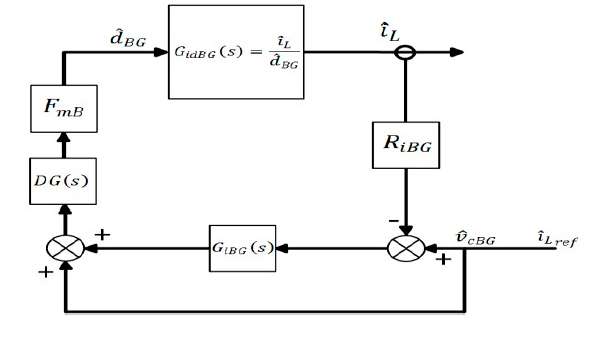
Figure 4. Block diagram in grid